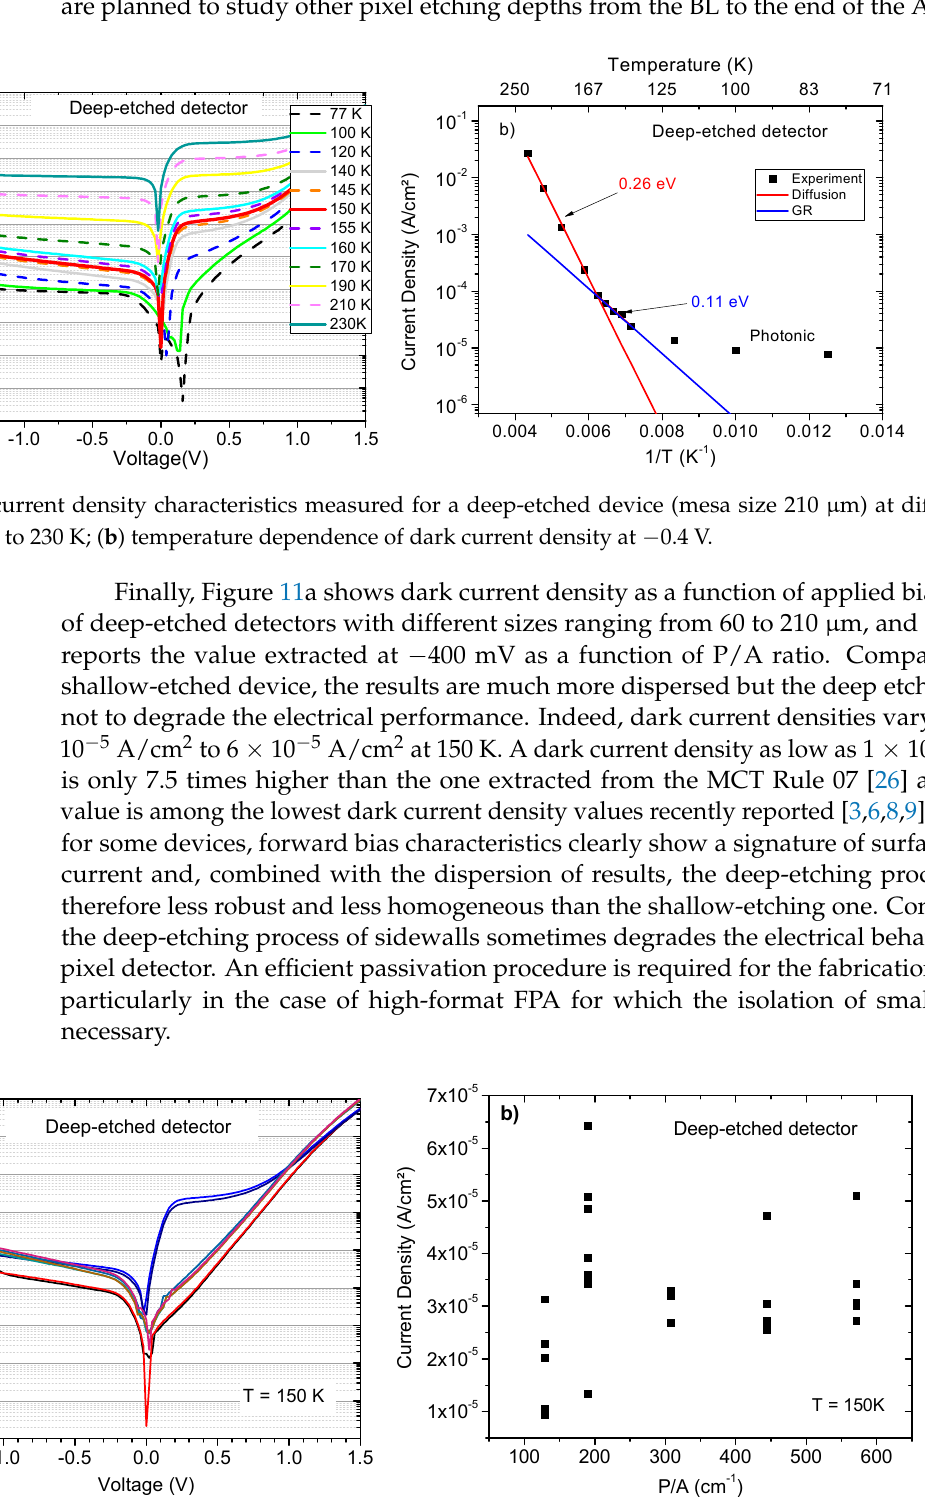
Figure 9. Quantum efficiency (QE) at λ = 3.4 µm of the deep-etched photodetector for T = 90, 150 and 220 K versus applied bias. At T = 150 K, the QE is equal to 60 % at the operating bias (V = − 0.4 V).